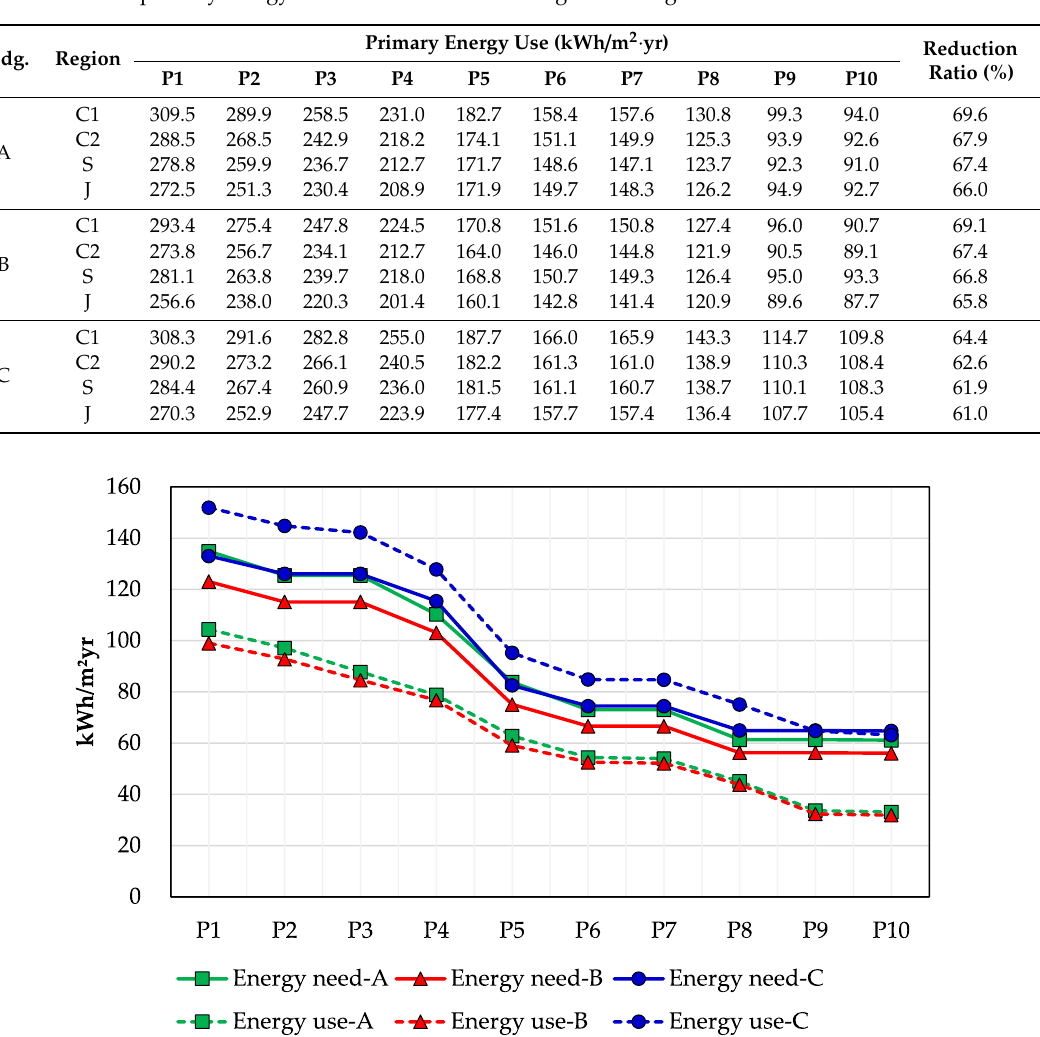
Figure 5. Trend of reduction in energy use and need with the reinforcement of the BECC in the C2 region.